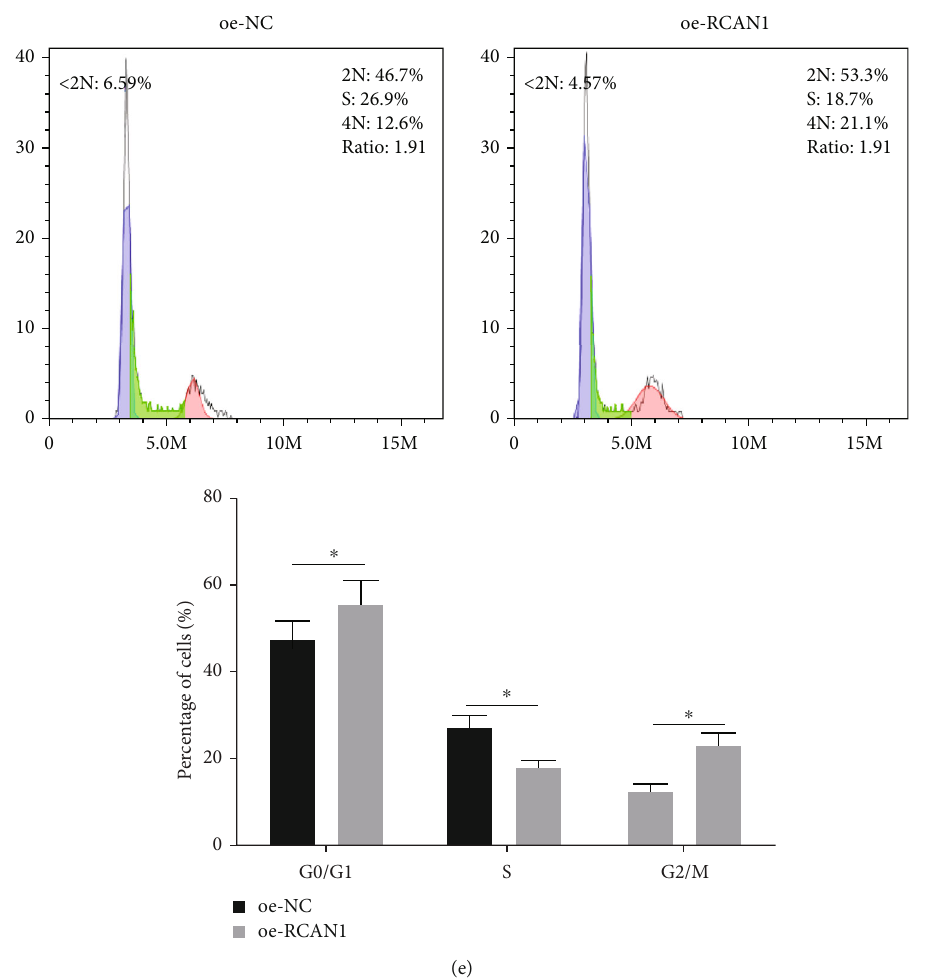
Figure 2: Overexpression of RCAN1 inhibits the progression of liver cancer cells. (a) The transfection e ffi ciency of RCAN1 in liver cancer cells Hep3b was detected by qRT-PCR; (b) the proliferative ability of Hep3b cells in di ff erent transfection groups was assessed through CCK-8 assay; (c) the invasive ability of Hep3b cells in di ff erent transfection groups was detected by Transwell assay (100 × ); (d) the migratory ability of Hep3b cells in di ff erent transfection groups was measured via wound healing assay (40 × ); (e) changes of Hep3b cell cycle in di ff erent transfection groups were assessed through fl ow cytometry; ∗ p < 0 : 05